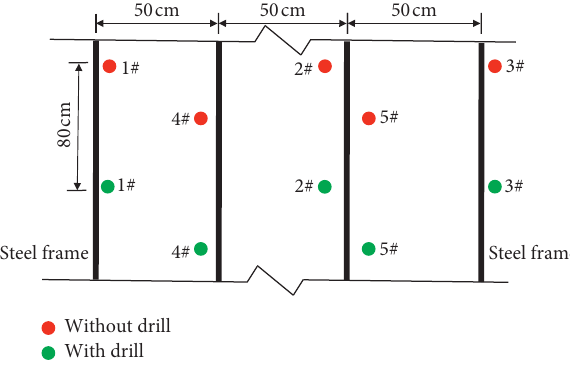
Figure 20: Distribution of first test